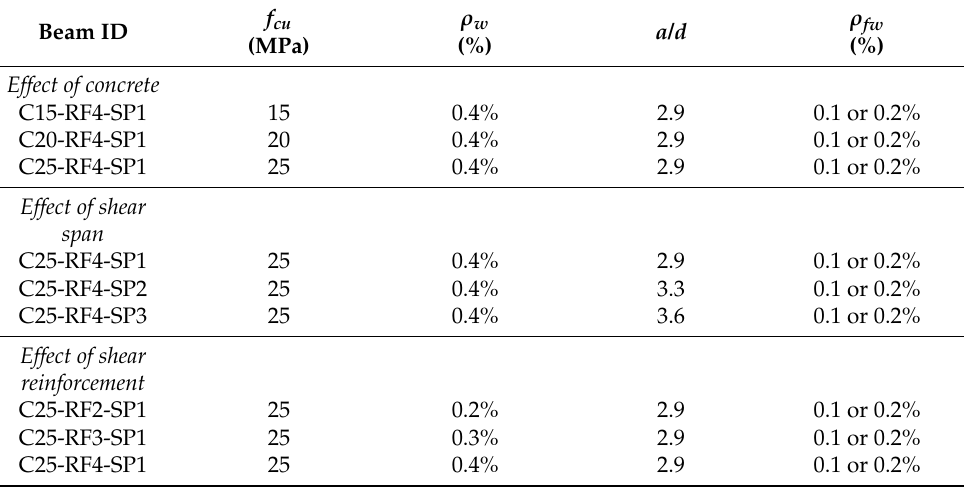
Table 7. Variation of parameters for parametric FE study.